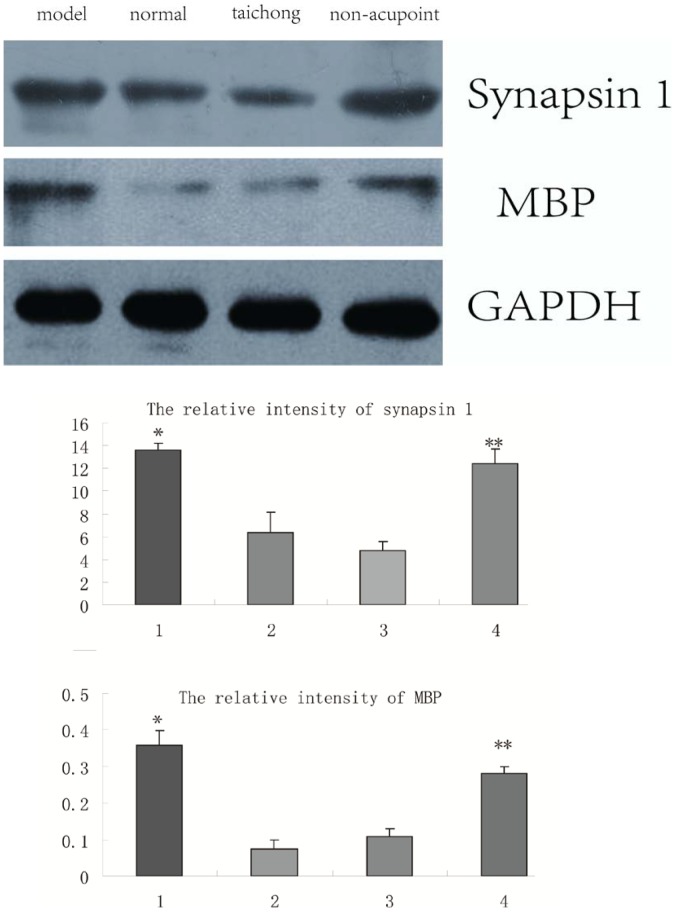
Blots of Western blot assays for synapsin-1 and myelin basic protein (MBP) in the medulla of SHRs.*P<0.05; **P<0.01.